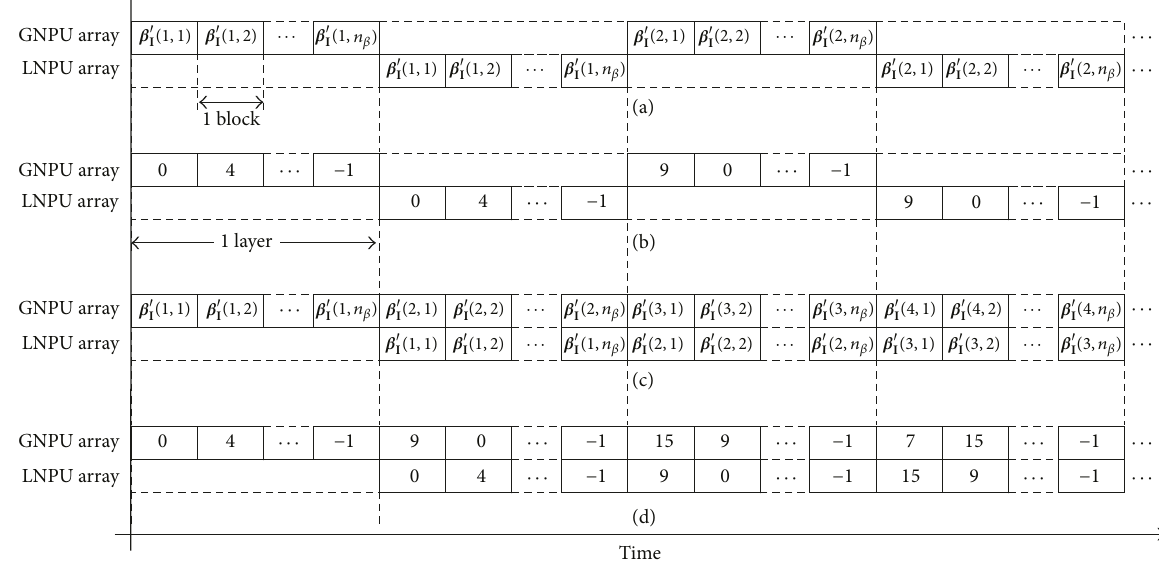
Figure 6: Block-level view of the pipeline timing diagram. (a) General case for a circulant- 1 identity submatrix construction based QC- LDPC code (see Section 2) without pipelining. (b) Special case of the IEEE 802.11n QC-LDPC code used in this work without pipelining. (c) Pipelined processing of two layers for the general QC-LDPC code case in (a). (d) Pipelined processing of two layers for the IEEE 802.11n QC-LDPC code case in (b). This schedule is illustrated by the block processing loop in the high-level decoder architecture shown in Figure 9. Here, 𝑛 𝛽 represents the number of columns of 𝛽 󸀠 I .